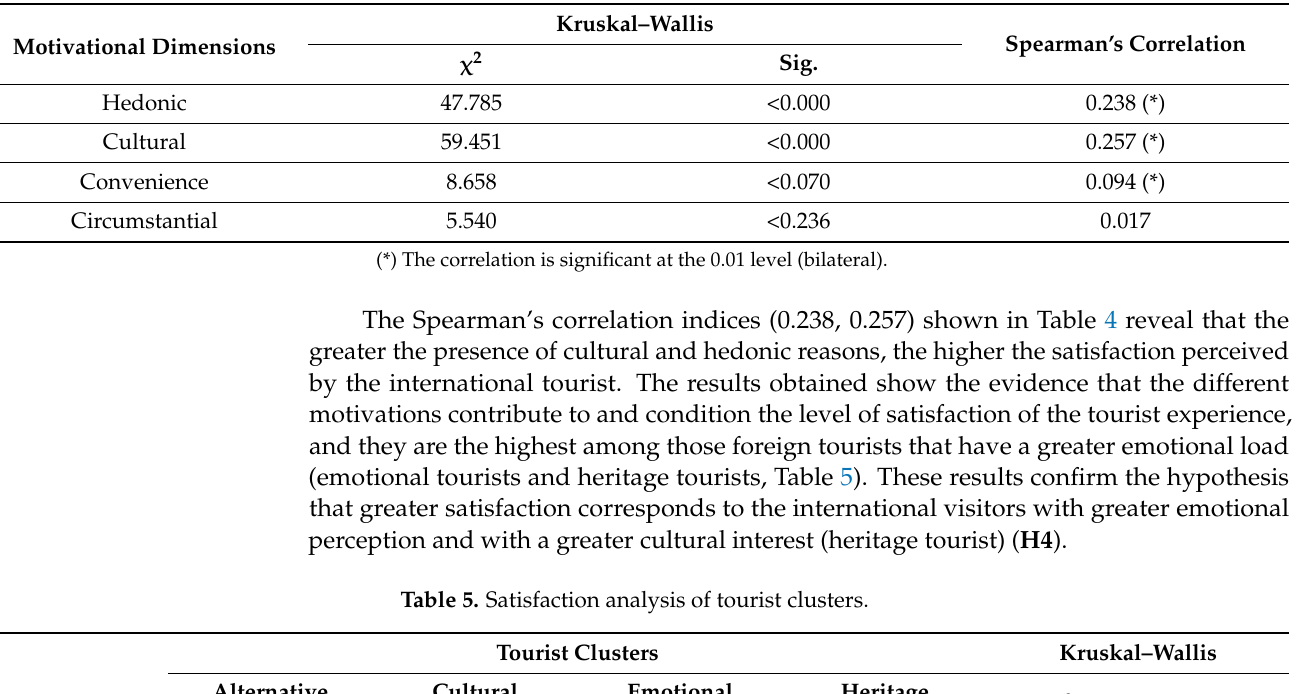
Table 4. Motivational dimensions and satisfaction of the visit.